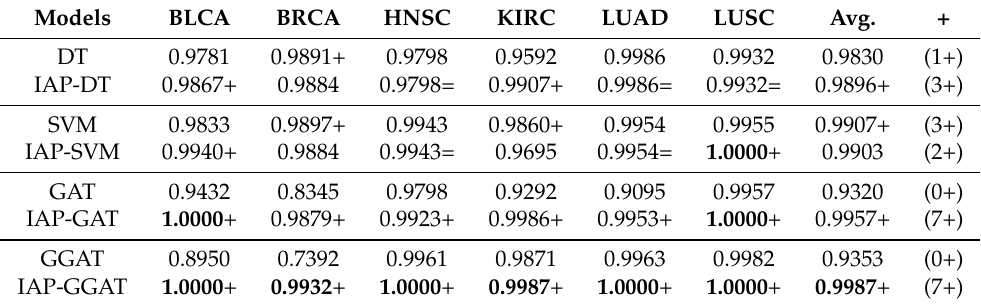
Table 4. Recall on all datasets.